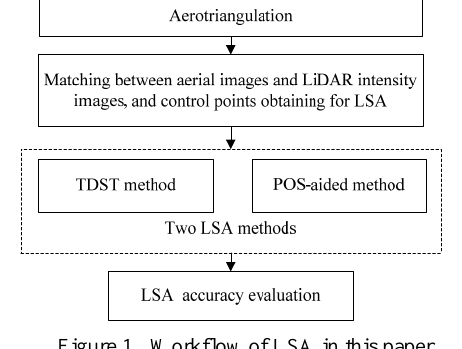
Figure 1. Workflow of LSA in this